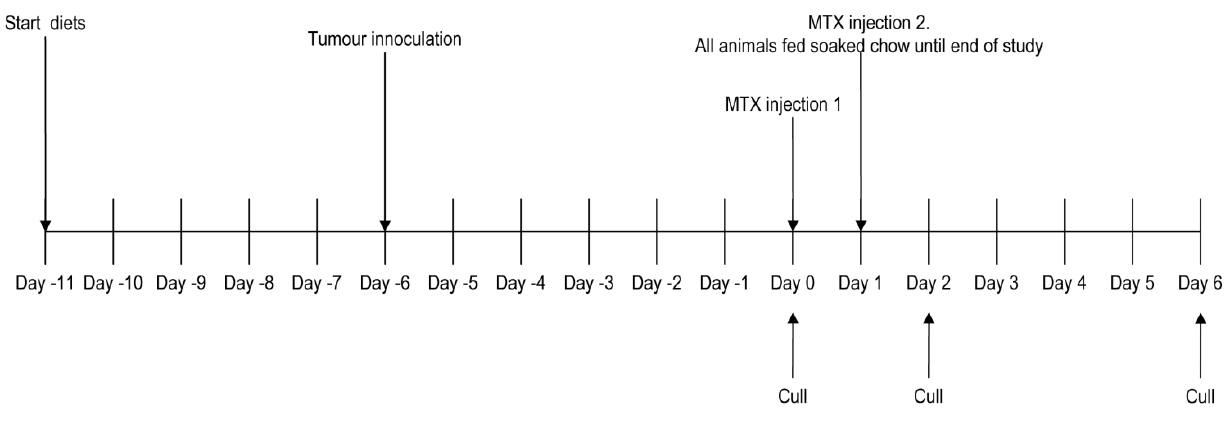
Figure 1. Experimental flow chart for study